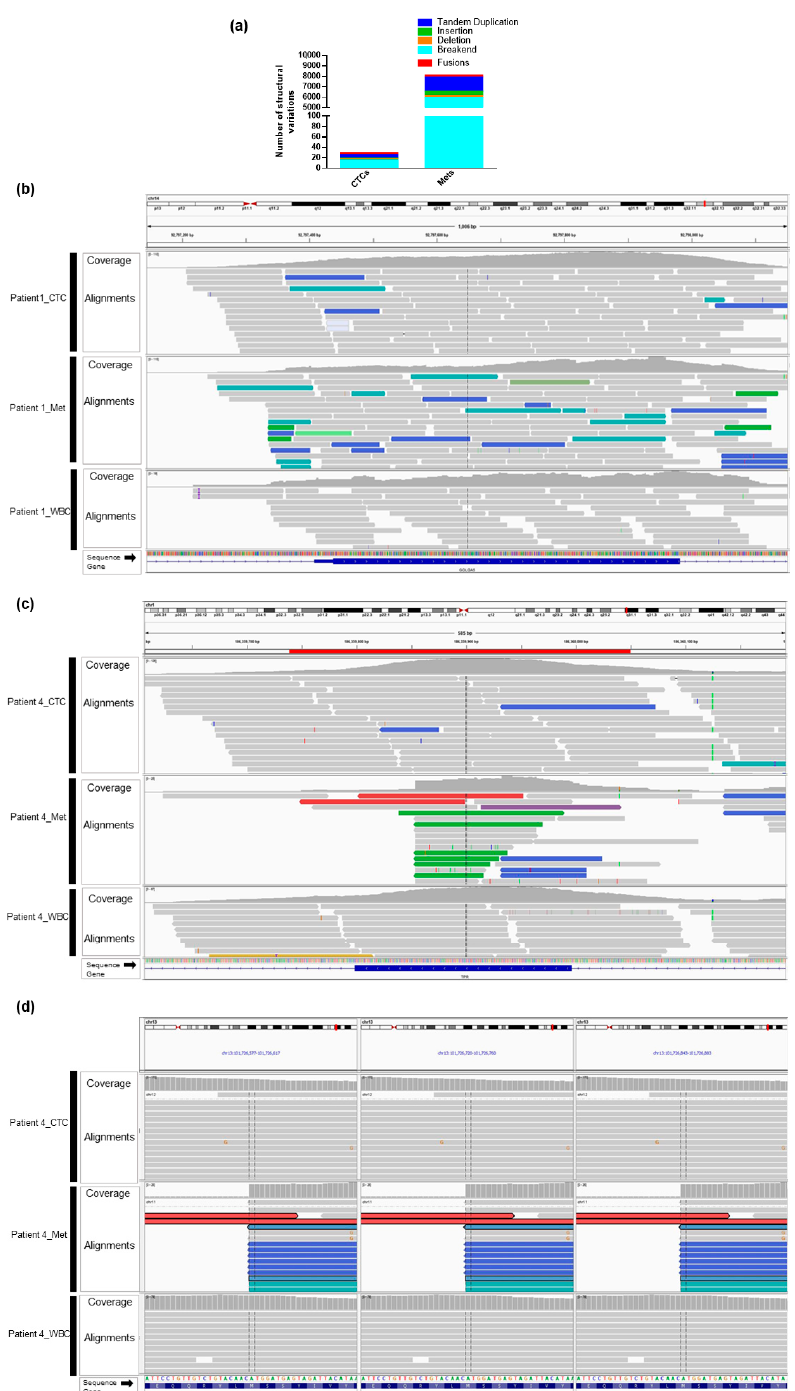
Figure 3. Overview of somatic structural variants (SVs) in CTCs and matched metastatic tissues. ( a ) Distribution of somatic SVs in CTCs and metastatic tissue depicting a high proportion of translocation breakendsandtandemduplications. ( b )ScreenshotfromIGVshowingthecoverageandreadalignments (gray) in CTCs, metastases, and WBCs of patient #1 and inversions in colored bars (teal and blue) in the GOLGA5 gene. There is no inversion in the matched WBC sample. ( c ) Screenshot from IGV showing the coverage and read alignments (gray) in CTCs, metastases, and WBCs of patient #4 and duplications (green) in the TPR gene. There is no duplication in the matched WBC sample. ( d ) Split-screen view from IGV showing the translocation breakpoint in the FGF14 gene on chromosome 13 in patient #4 metastases. There is no translocation breakpoint in CTC and WBC